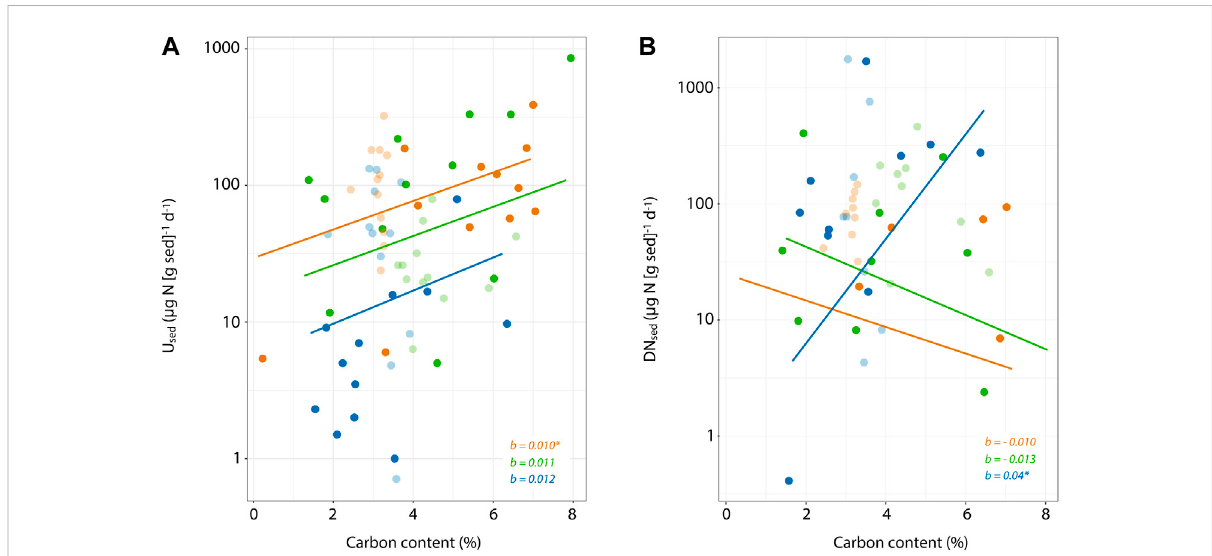
FIGURE 4 Relationships of sediment C content with sediment-speci fi cassimilatory uptakerates (A) and denitri fi cation rates (B) among sediment sources. Note vertical axis is log 10 transformed and that color legend is consistent with previous fi gures. Slope lines were computed including data from both size fractions for each sediment source, and their values and signi fi cance ([blank] p > 0.05; * p < 0.05; **, p < 0.01; *** p < 0.001) are indicated in each panel. DN sed values below our detection limit are omitted in the plot but were considered for the slope